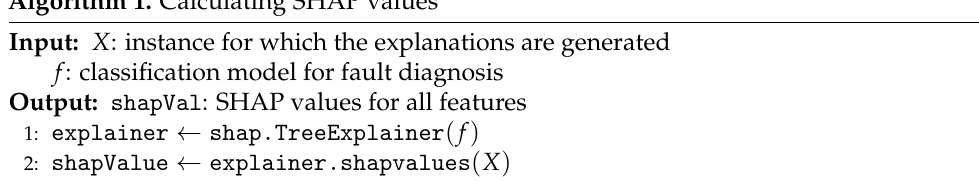
Algorithm 1. Calculating SHAP